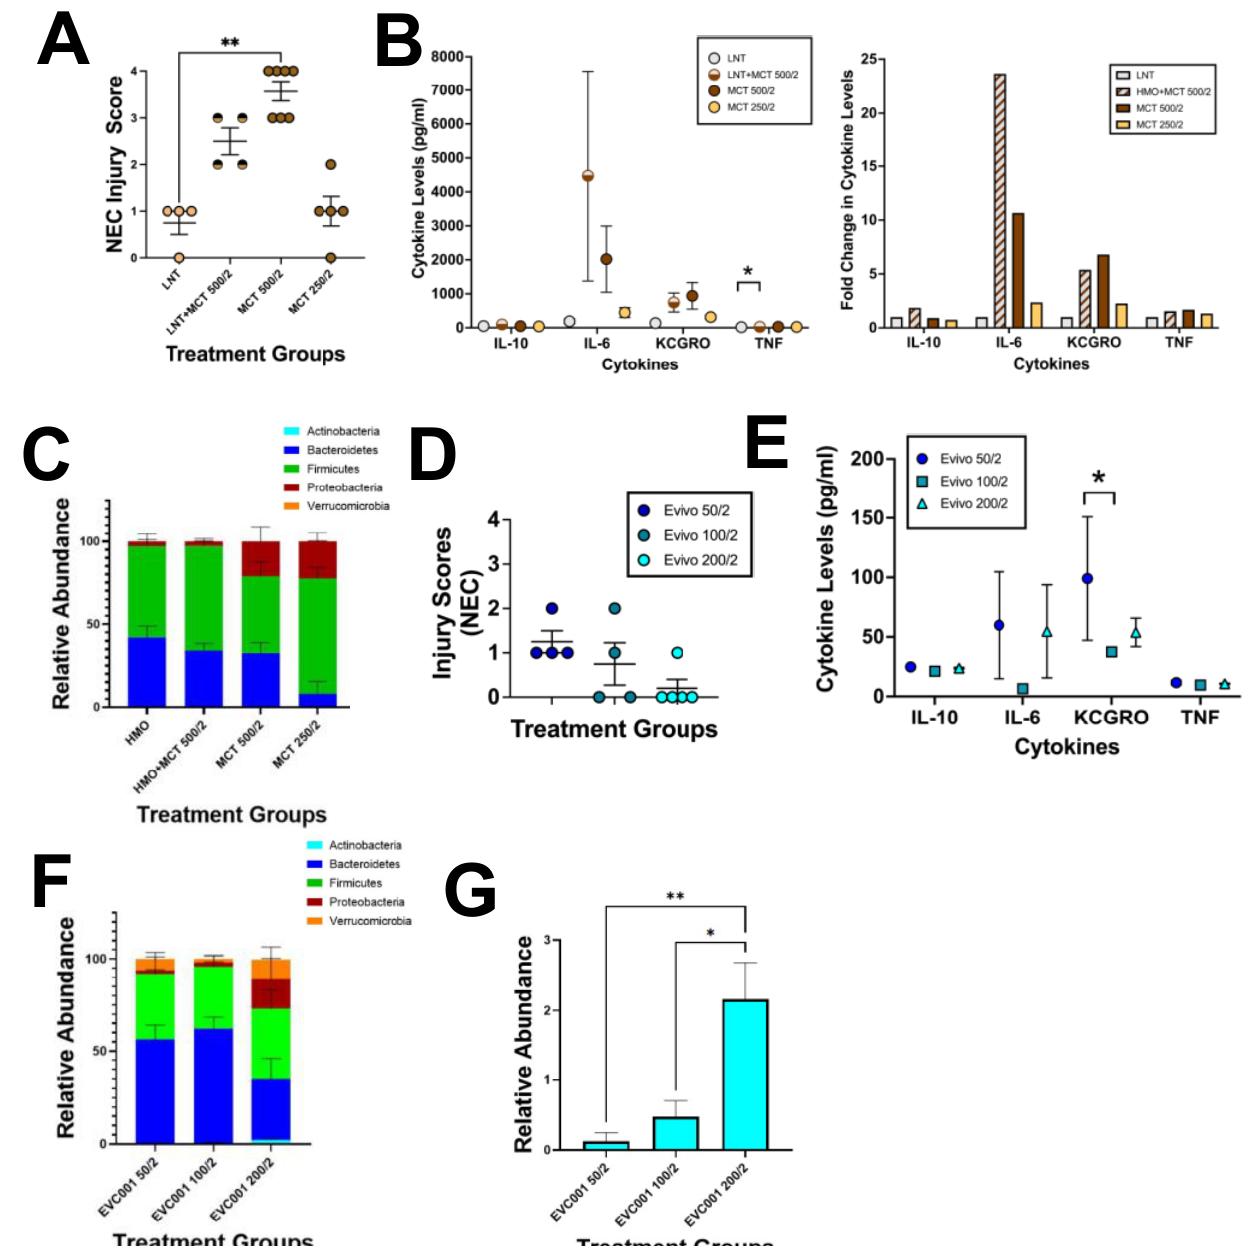
Figure 2. MCT oil in human-relevant doses is toxic to mice and must be tailored to size. ( A ) NEC injury scores for mice receiving MCT oil with or without gavage of LNT ( n ≥ 4 mice per group). ( B ) Serum cytokine analysis for IL-10, IL-6, KC-GRO, and TNF for mice given MCT oil with or without gavage of LNT ( n ≥ 4 mice per group). ( C ) Cecal microbiome analysis of the phylum-level relative abundances for mice given MCT oil with or without gavage of LNT ( n ≥ 4 mice per group). ( D ) NEC injury scores for mice receiving varying doses of probiotic EVC001 ( n ≥ 4 mice per group). ( E ) Serum cytokine analysis for mice receiving varying doses of EVC001 ( n ≥ 4 mice per group). ( F ) Cecal microbiome analysis of the phylum-level relative abundances for mice given varying doses of EVC001 ( n ≥ 4 mice per group). ( G ) Cecal microbiome Bifidobacteriaceae family level relative abundances for mice given varying doses of EVC001 ( n ≥ 4 mice per group). For all p values, * ≤ 0.05, ** ≤ 0.01.